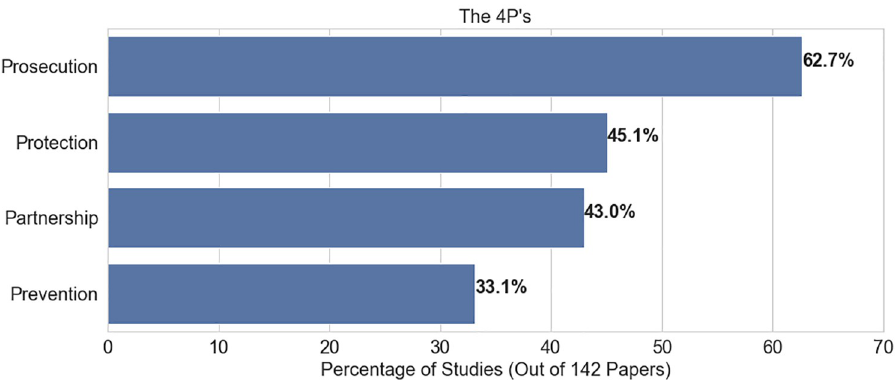
Fig 6. Percent of studies involving